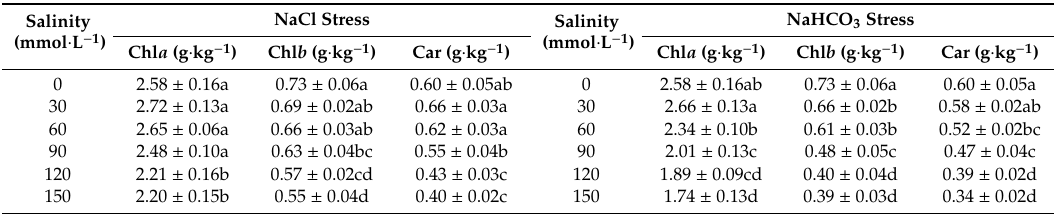
Table 1. E ff ects of NaCl and NaHCO 3 stresses on the content of chlorophyll (Chl) a , b , and total carotenoids (Car) in common bean ( Phaseolus vulgaris )